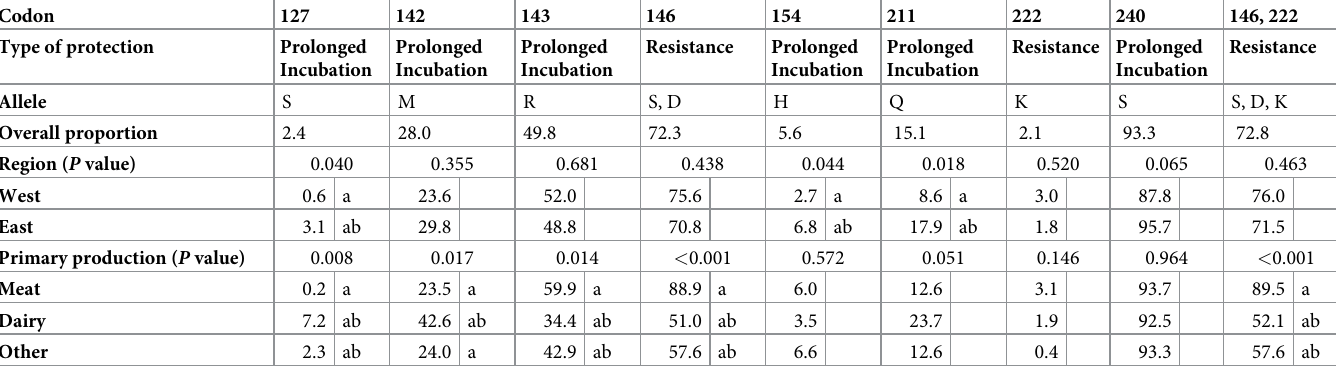
Capital letter coding denotes which levels of a given breakout variable have significantly different proportions of operations with any goats with the prolonged incubation or resistant genotypes. Levels that share a letter are not significantly different and levels that do not share a letter are significantly different at the 0.05 significance level with Tukey-Kramer